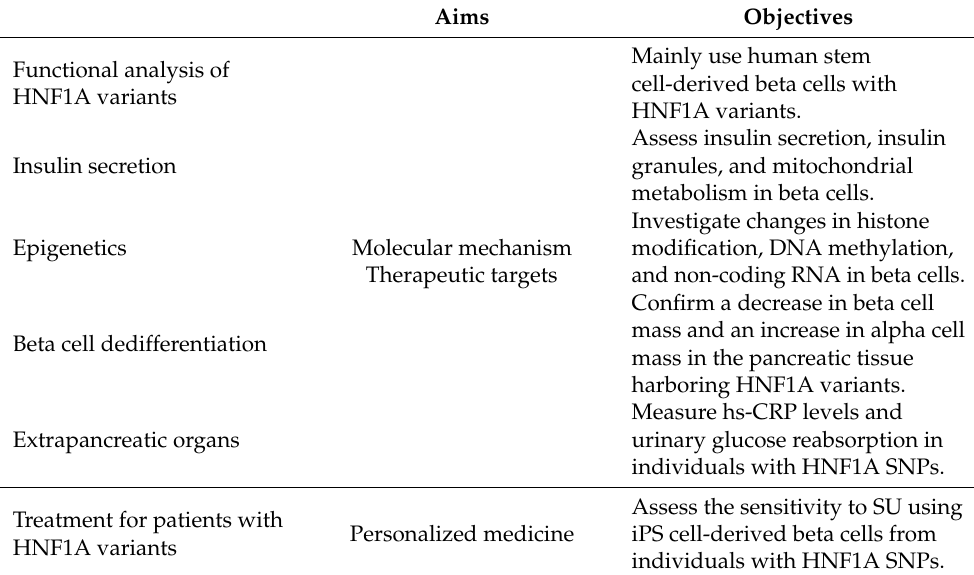
Table 2. Future research